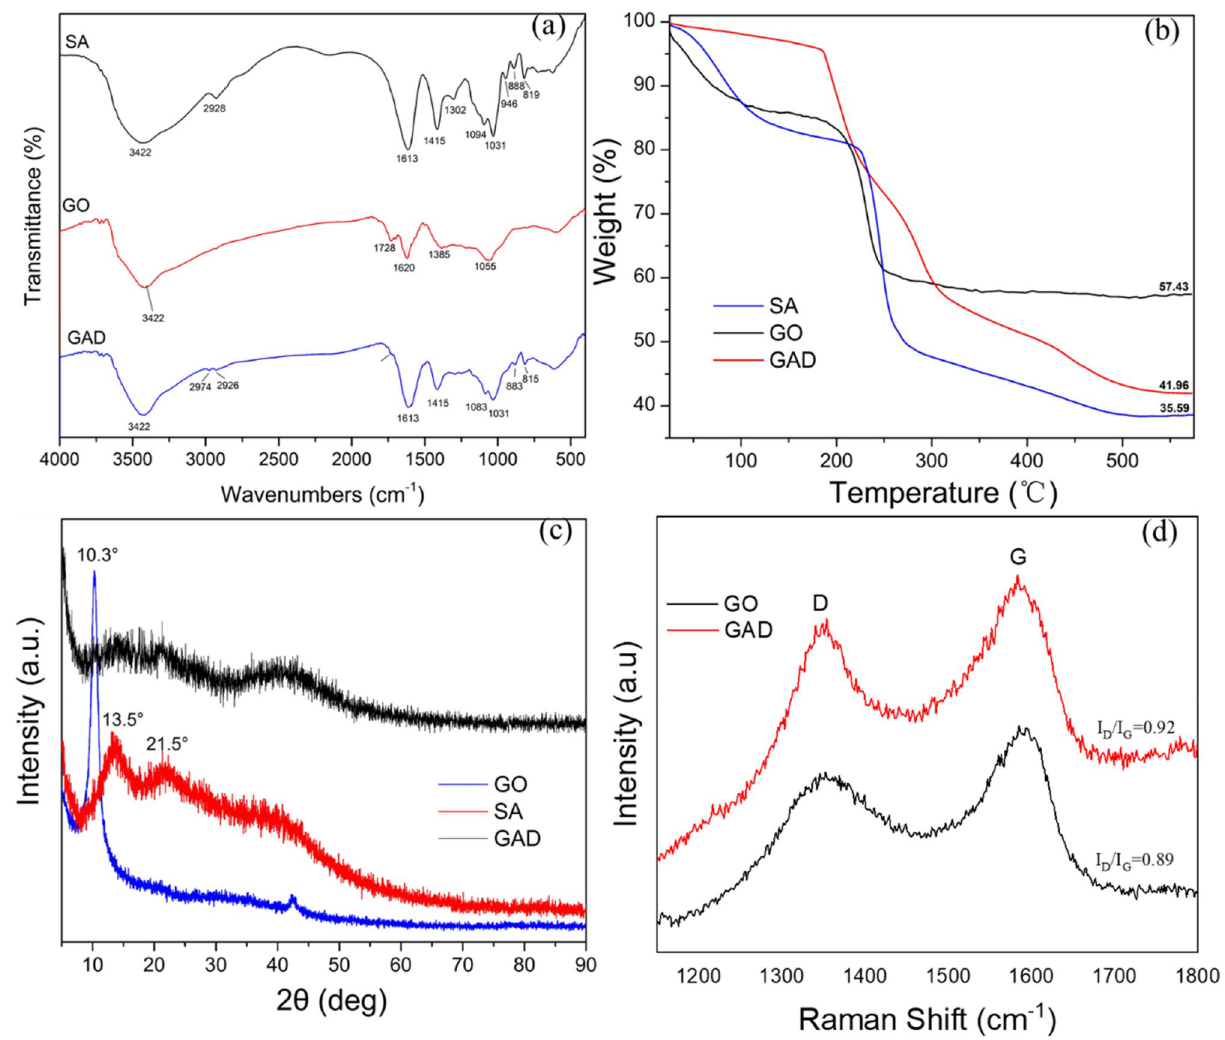
Figure 2. ( a ) FTIR spectra of SA, GO and GAD, ( b ) TGA of SA, GO, and GAD, ( c ) XRD of SA, GO, and GAD, ( d ) Raman spectra of GAD and GO.